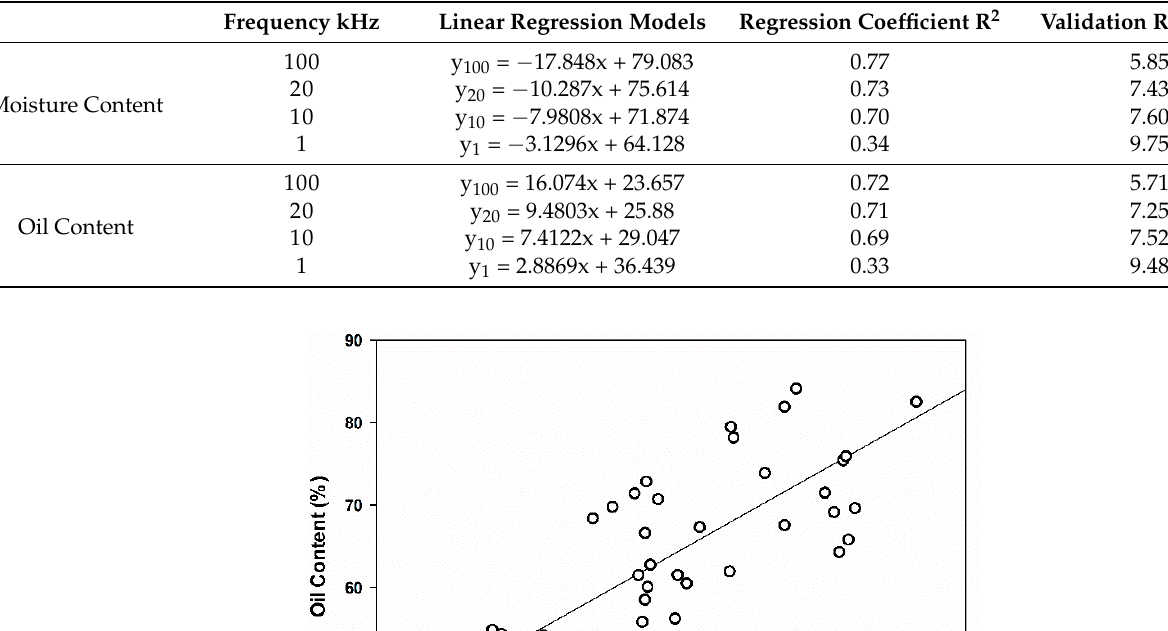
Table 5. Linear regression model and RMSE validation for moisture and oil content.